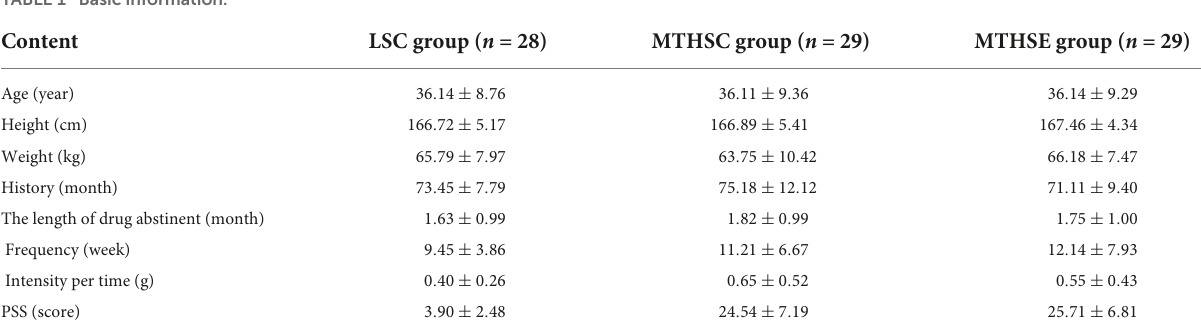
FIGURE1 Screening flow chart.